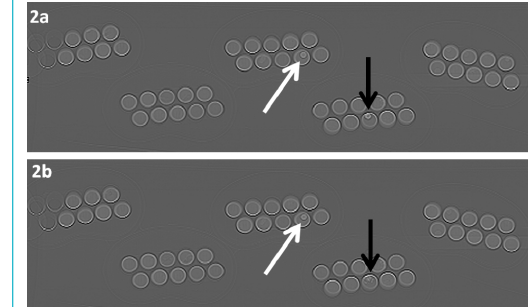
Figure 2: Pre-scan CT-scout of the 50 plastic cups (view from above). (a) 5 minute after submerging the pills into hydrochloric acid. (b) 30 minutes after submerging the pills. The white arrow point towards the stable potassium pill (KCl Retard) and the black arrow demonstrates the decay of